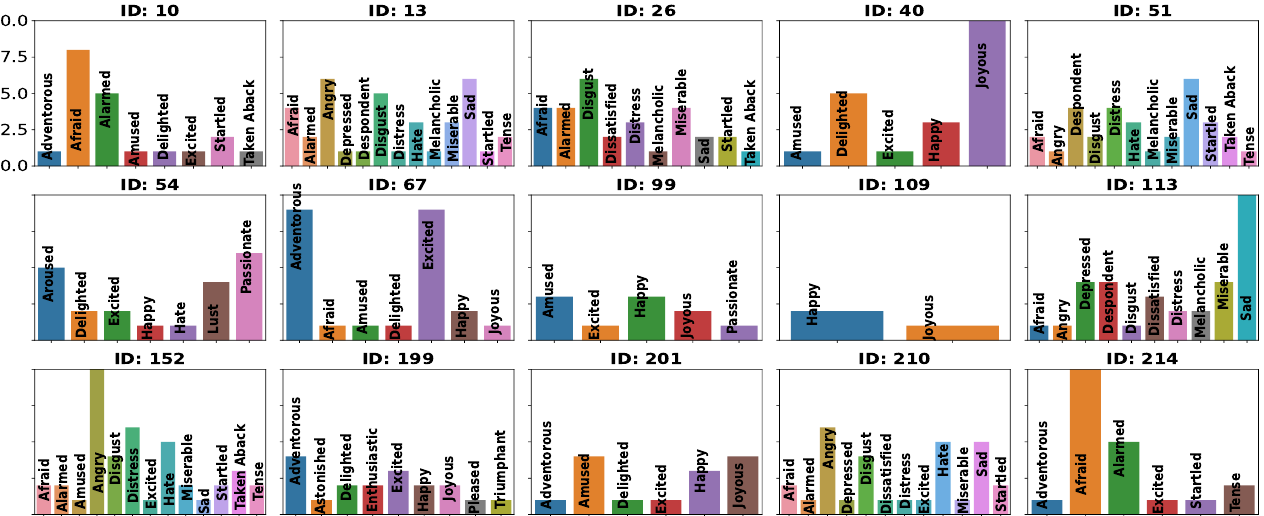
Figure 4. The figure shows the distribution of emotion categories in which participants rated their emotional events while watching the stimulus. The title of each subgraph shows stimulus ID. The number of times participants rated an emotional category is shown on the